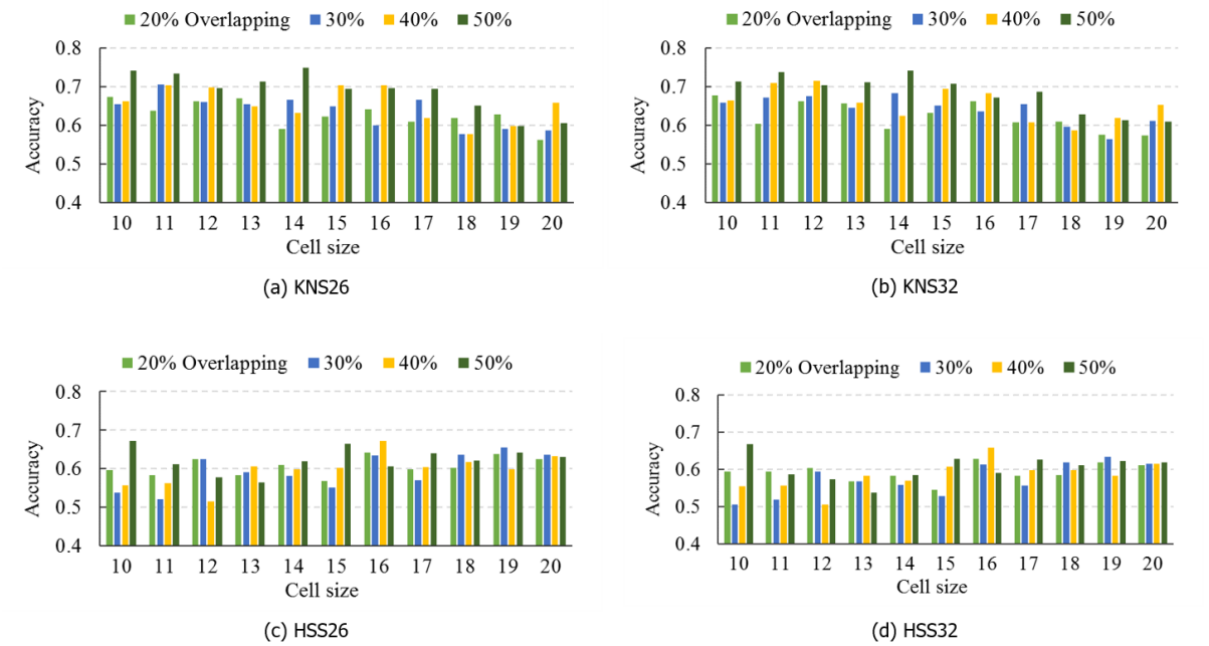
Figure 5. Classification accuracies for the NYU Langone Medical Center: Sample 1 dataset using 4 histogram-based morphometry (HBM)